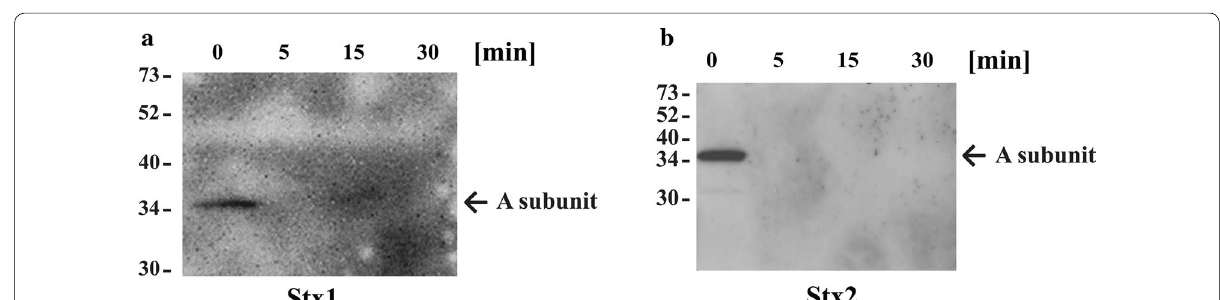
Fig. 3 Western blotting of Stx1 and Stx2 after nitrogen gas plasma treatment. A coverslip containing dried spots from 20 μl aliquots of a 1 μg/ml solution of Stx1 ( a ) and Stx2 ( b ) was treated with nitrogen gas plasma using BLP-TES device (1.5 kpps) for 0, 5, 15, or 30 min. The recovered samples were subjected to Western blotting using antibody recognizing the A subunit of